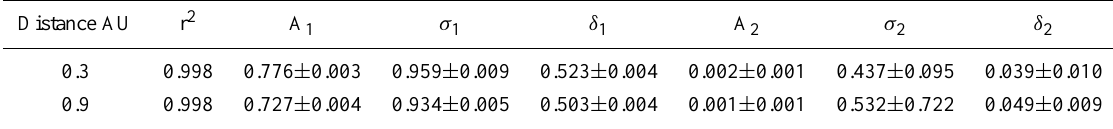
Table 4. Slow Wind: Values of the parameters obtained from the fit of the PDF relative to vector displacements. Distance AU